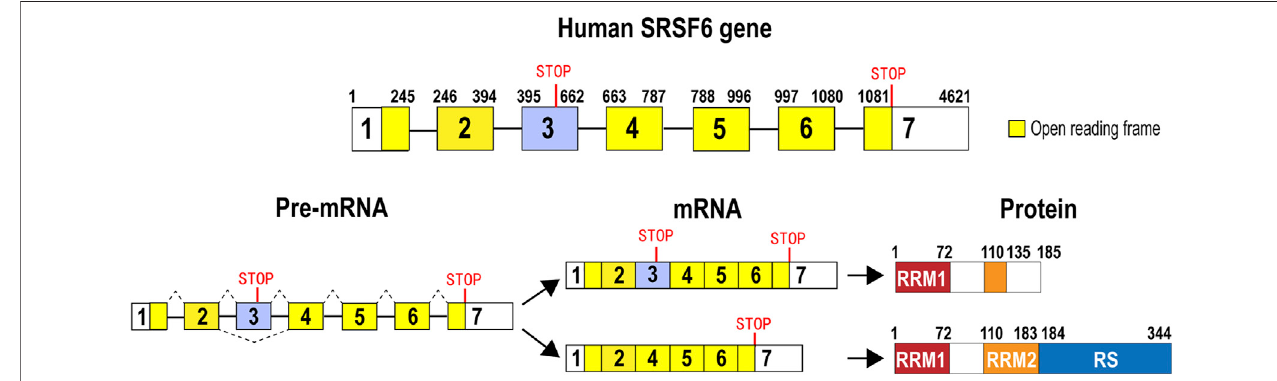
FIGURE 1 | Gene, pre-mRNA, mature mRNA, and encoded protein structure of human SRSF6. Human SRSF6 gene contains 7 exons. Exon 3 is an alternative exon and contains an in-frame pre-mature stop codon. Transcripts with exon 3 may encode a truncated SRSF6. Transcripts without exon 3 encode full-length SRSF6 protein that has two RNA recognition domains (RRM1 or RRM2) and an arginine and serine-rich domain (RS).